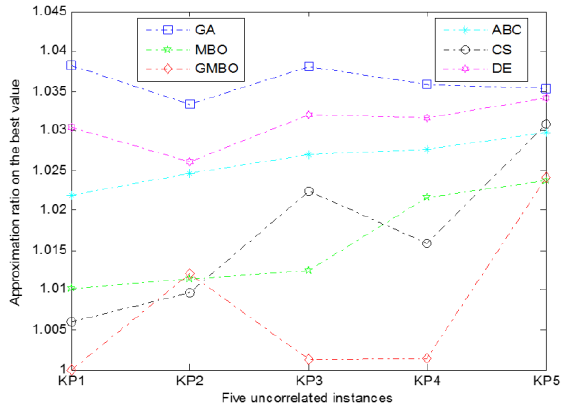
Figure 4. Comparison of ARB for KP1-KP5.